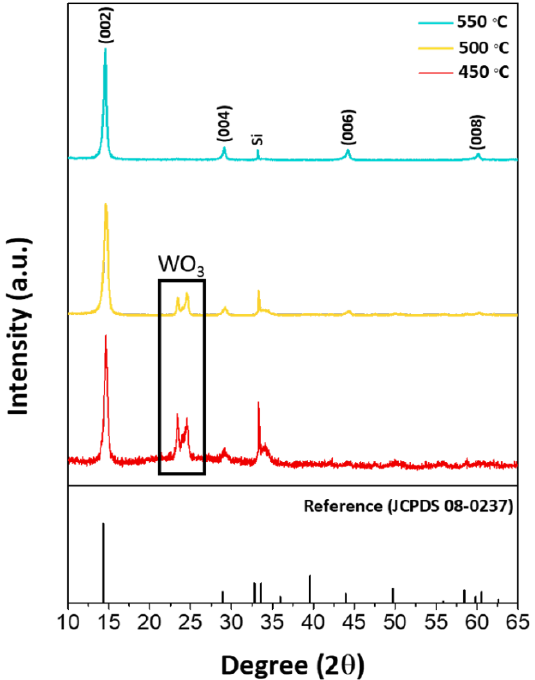
Figure 3. XRD patterns of vertically oriented WS 2 nanosheets grown on a Si substrate at 450, 500 and 550 °C.